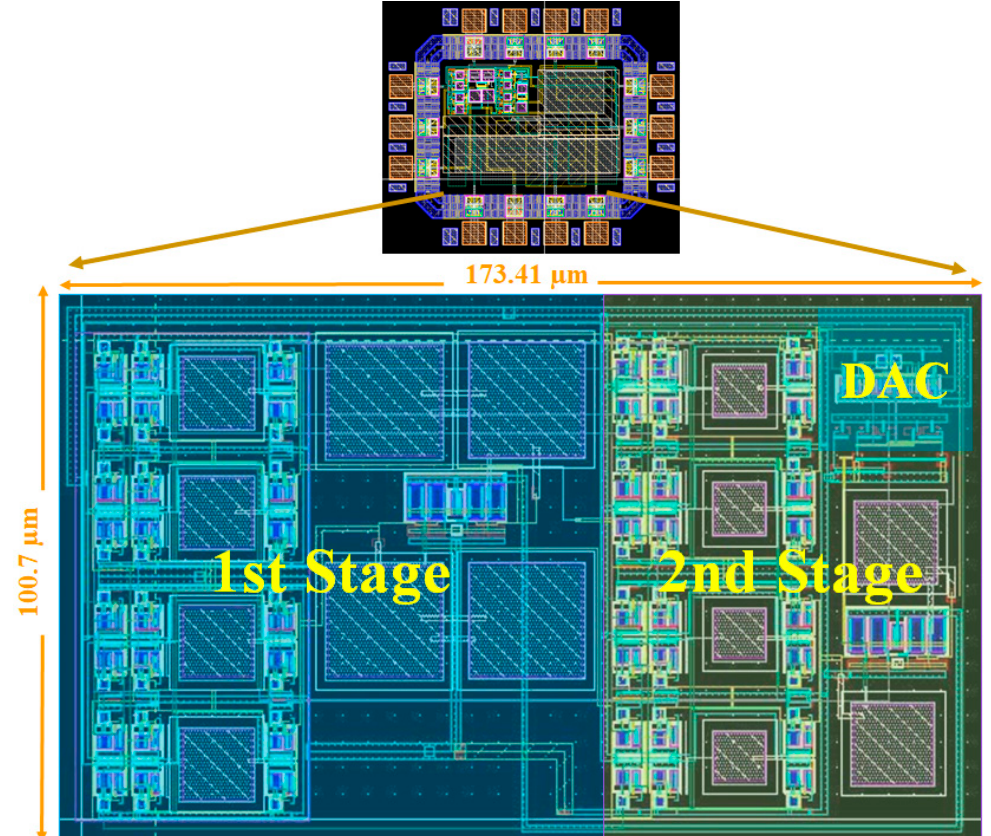
Figure 22. The proposed ∆Σ modulator’s layout and floorplan. In addition, corner and power supply tests were performed for post-layout Table 8. The proposed modulator’s validation. A Monte Carlo (Figure 23) analysis with 50 iterations and 16,384 points was performed for the proposed modulator to evaluate SNDR stability against various